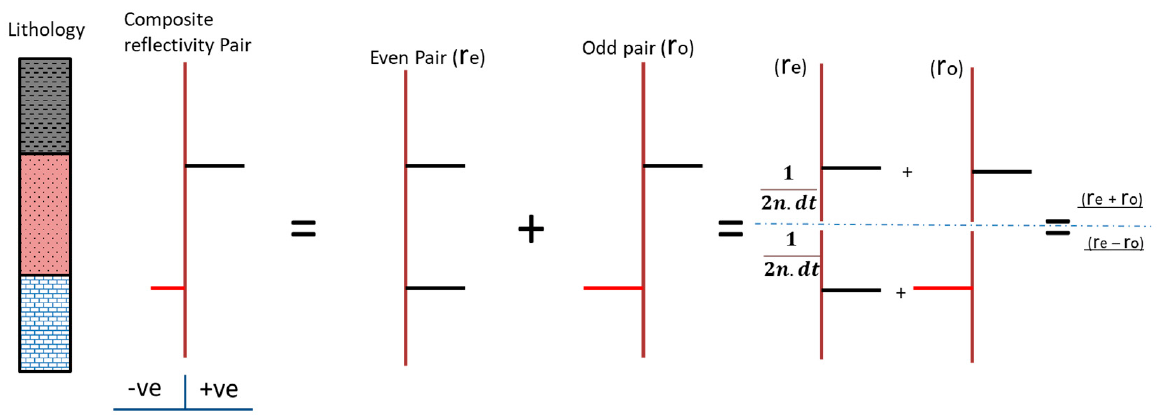
Figure 8. Any arbitrary pair of reflection coefficients r 1 and r 2 (Figure 7) can be represented as the sum of even and odd components. The even pair has equal magnitude and sign, and the odd pair has equal magnitude and opposite sign. The even and odd pair can be further decomposed into unit even and odd pairs